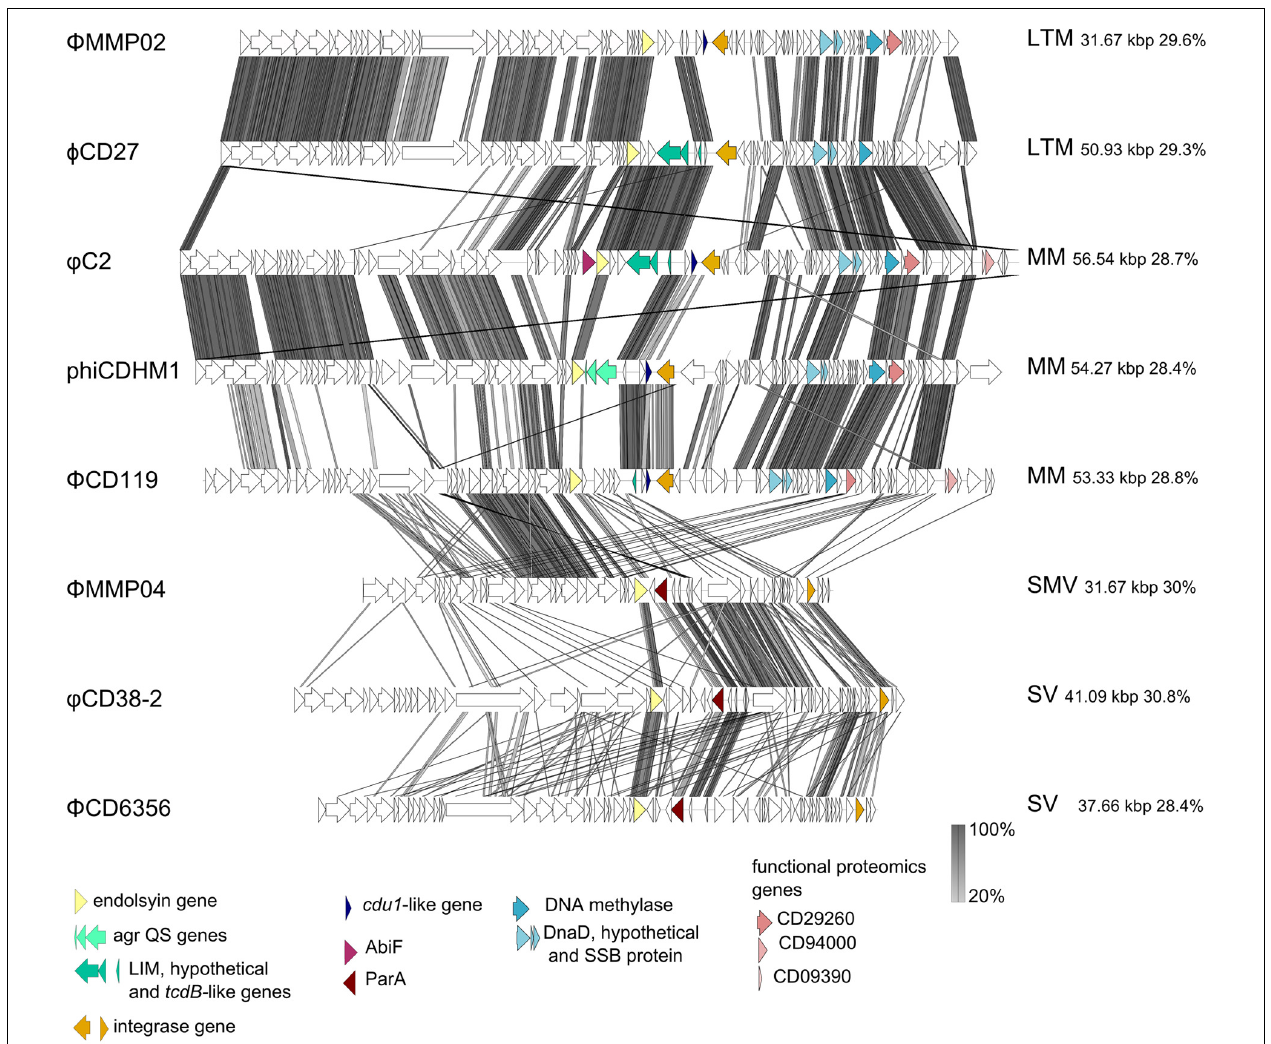
FIGURE 3 | Sequenced C. difficile phage genome similarity and content. Phage genomes were searched using tblastpx against one another and genome maps were generated using EasyFigv2.1 (Sullivan etal., 2011). The most similar phages are adjacent to one another, phage names are on the left hand side and phage morphological type, genome size and GC content are on the right hand side. The acronyms designate long tailed myovirus (LTM), medium myovirus